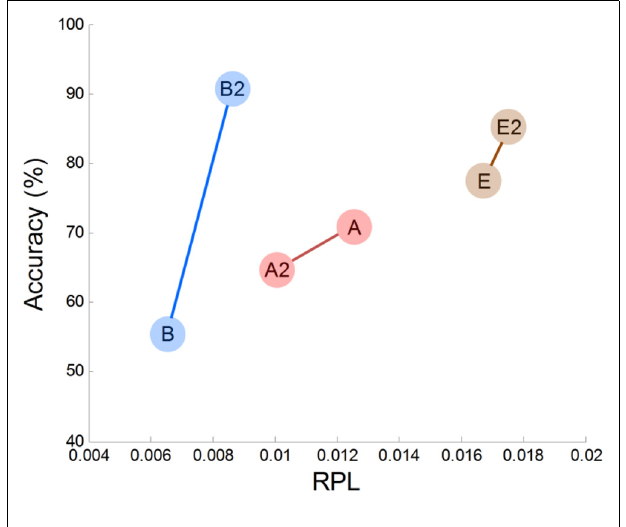
FIGURE 8 | Prefrontal MEG gamma and accuracy variation in two sessions